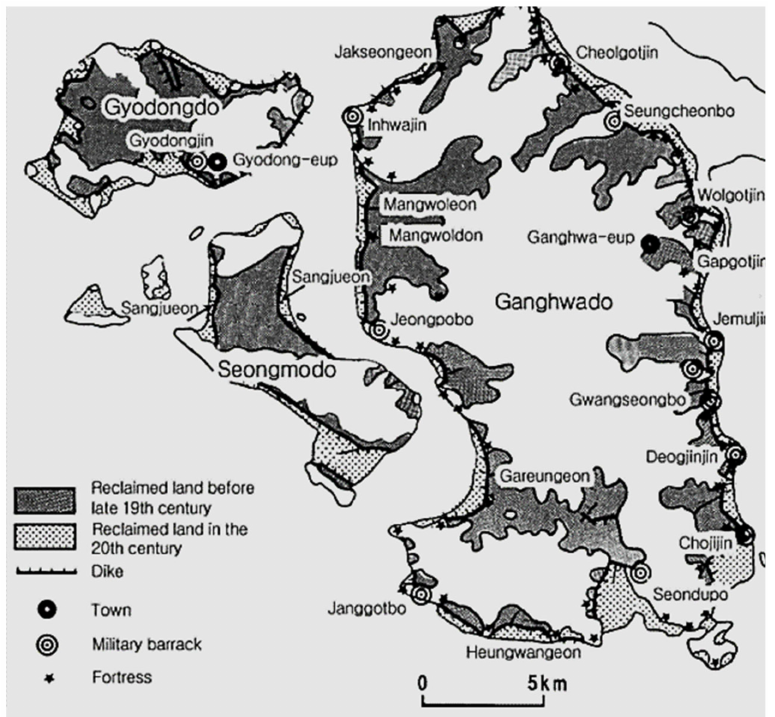
Figure 4. Reclaimed land between the late 19th and 20th century, showing towns, military barracks, and forts. Reprinted with permission from Ref. [14]. 1997, Choi,